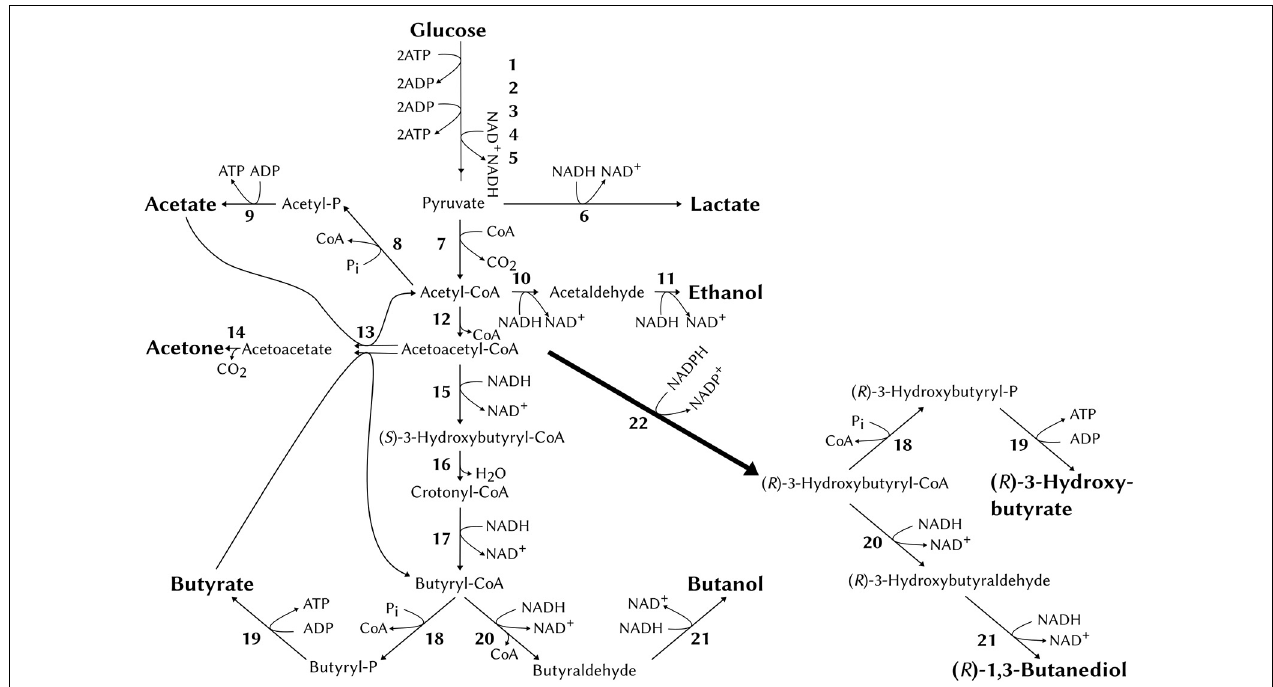
FIGURE 1 | The natural acid- and solvent- producing pathways of C. saccharoperbutylacetonicum and the heterologous pathway from acetoacetyl-CoA via PhaB (acetoacetyl-CoA reductase, 22). Numbers correspond to enzymes as follows: 1, hexokinase; 2, phosphoglucose isomerase; 3, phosphofructokinase; 4, glyceraldehyde-3-phosphate dehydrogenase; 5, pyruvate kinase; 6, lactate dehydrogenase; 7, pyruvate-ferredoxin oxidoreductase; 8, phosphate acetyltransferase; 9, acetate kinase; 10, acetaldehyde dehydrogenase; 11, ethanol dehydrogenase; 12, thiolase; 13, acetoacetyl-CoA:acetate:CoA transferase/acetoacetyl-CoA:butyrate:CoA transferase; 14, acetoacetate decarboxylase; 15, β -hydroxybutyryl-CoA dehydrogenase; 16, crotonase; 17, butyryl-CoA dehydrogenase; 18, phosphotransbutyrylase; 19, butyrate kinase; 20, butyraldehyde dehydrogenase; 21, butanol dehydrogenase; 22, acetoacetyl-CoA reductase ( phaB , from Cupriavidus necator